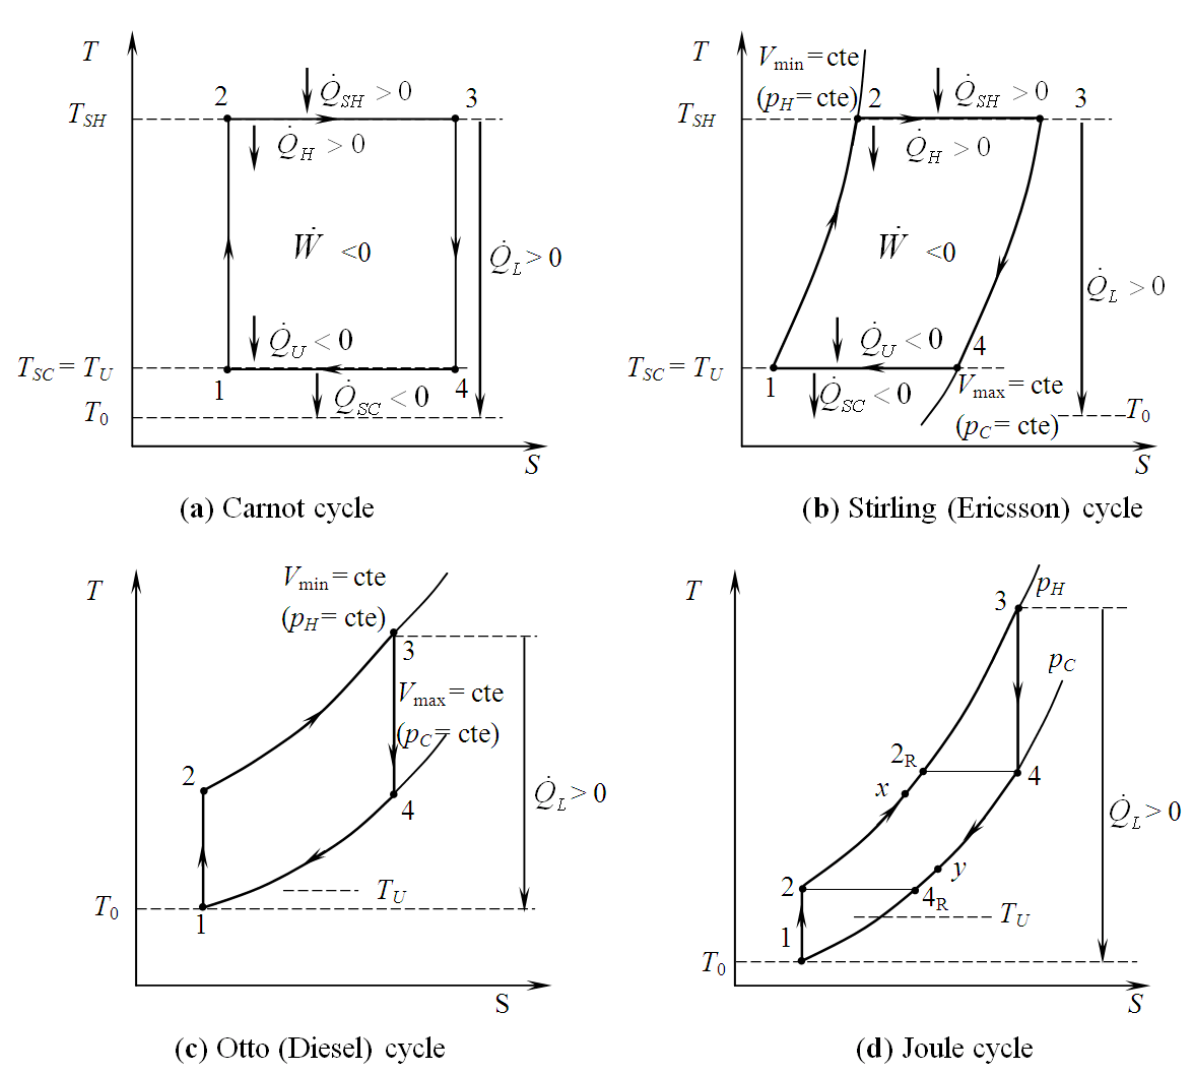
Figure 1. Equilibrium Thermodynamics of CHP thermo-mechanical engines: ( a ) and ( b ) –ECE; ( c ) and ( d )